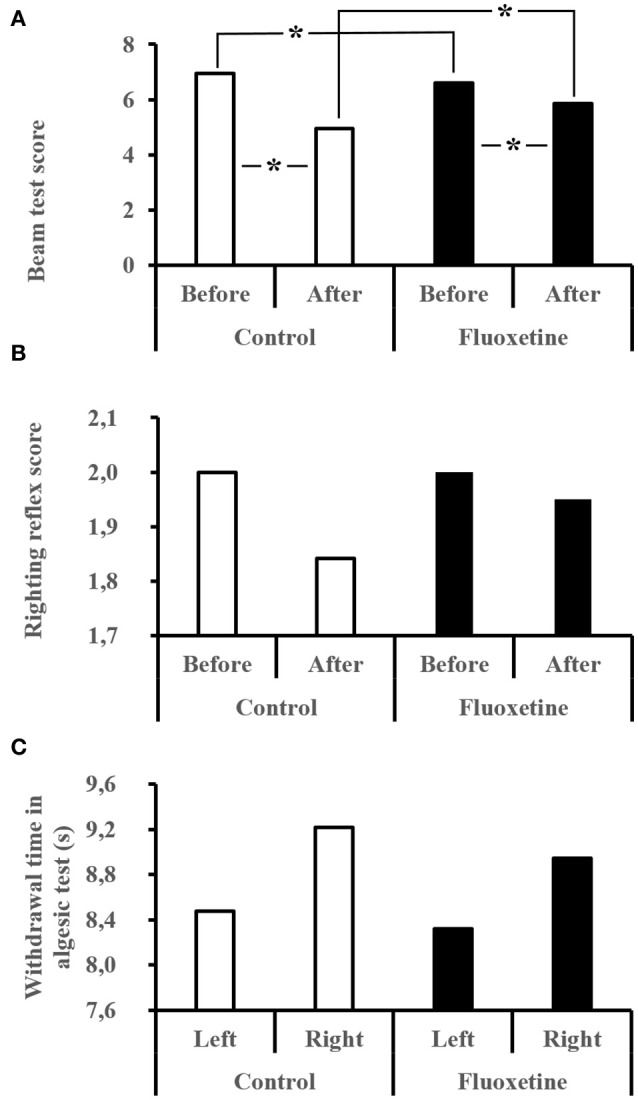
(A–C) Behavioral performances after the hyperbaric exposure. (A) Performance for the beam test. The best score is 1 and the worst is 7. (B) Righting reflex. The best score is 2 and the worst is 0. (C) Algesia test performed with infrared stimulation on left and right hind paws. Average time for the rat to remove the paw from the thermal stimulus. *Significant difference (p < 0.05).